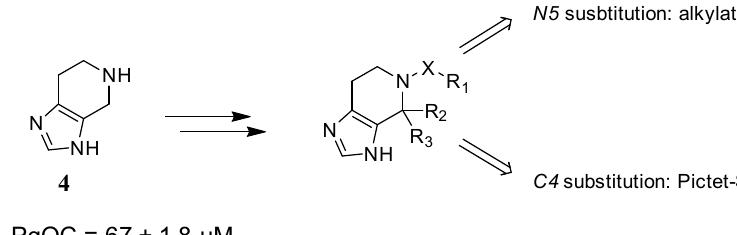
Figure 3. Possible decorations of the tetrahydroimidazopyridine scaffold.